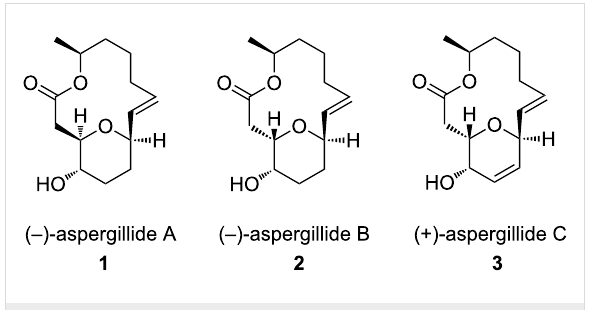
Figure 1: Structures of aspergillides.